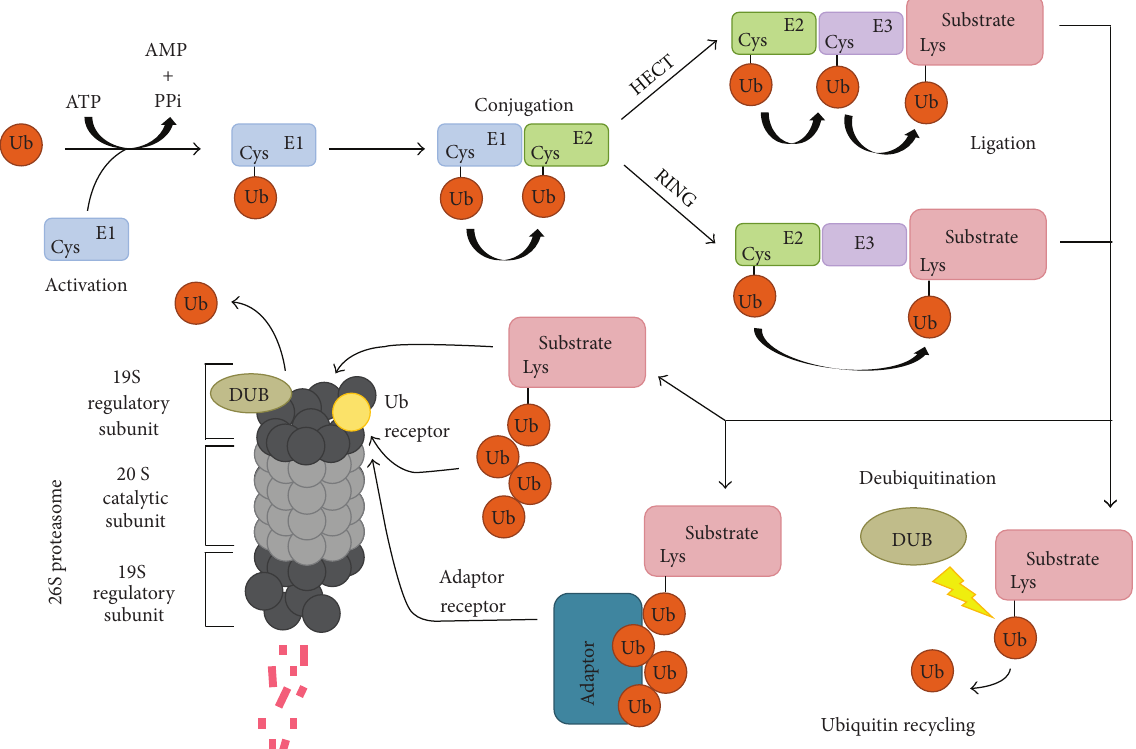
Figure 1: Enzymatic cascade leading to substrate ubiquitination. Three sets of enzymes are required for ubiquitination of a targeted substrate: ubiquitin-activating (E1), ubiquitin-conjugating (E2), and ubiquitin-ligase (E3) enzymes. There are two main classes of E3 enzymes, the RING and HECT classes, which differ in the manner by which they transfer Ub to a target substrate. Once a Ub molecule is conjugated to its target protein, additional Ub molecules can be attached to form chains (see Figure 2 for a more detailed illustration of Ub binding). However, since ubiquitination is a reversible process, once Ub is attached, deubiquitinating enzymes (DUBs) can then hydrolyze the isopeptide bond between Ub and its target protein (shown by the small lightning bolt) and thus return the protein to its previous state and release Ub. Substrates that contain polyUb chains are often targeted to the proteasome, where they are bound and subsequently degraded. The proteasome is composed of a catalytic 20S core particle structure and two 19S regulatory caps which together are collectively termed the 26S proteasome. While some polyubiquitinated proteins can be bound directly through polyUb binding subunits on the proteasome, others must be shuttled to the proteasome via adaptor proteins (the binding site for Ub and adaptors is represented by a yellow circle). Once the substrate is bound to the proteasome, many ATPase subunits that make up the proteasome utilize ATP to unfold the protein, simultaneously deubiquitinating the protein and releasing Ub while cleaving the protein into small peptide